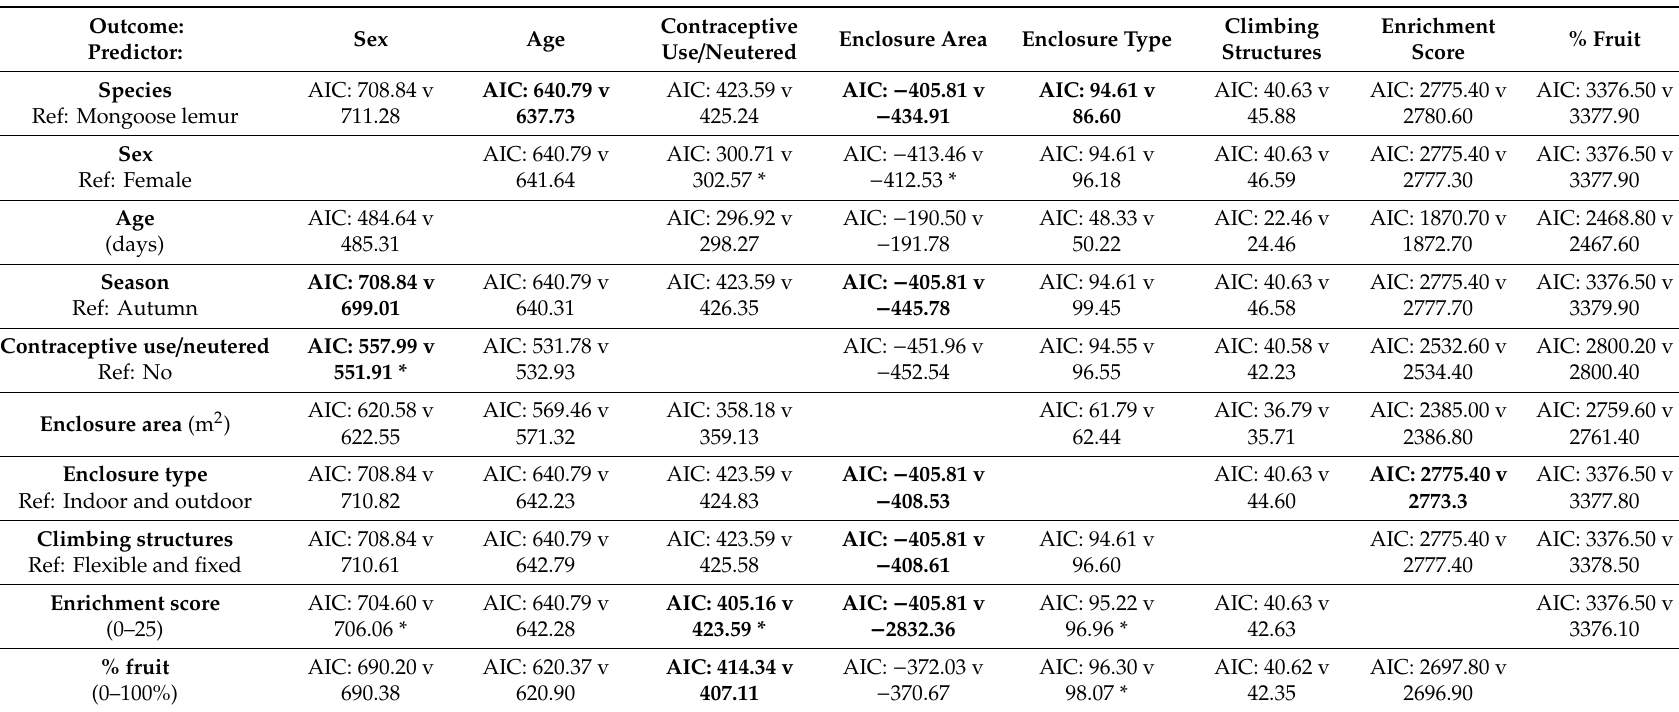
Table A4. Results of between-predictor checks for the epidemiological analyses. Note that species and season, being categorical with > 2 levels and nominal, were not analysable as outcome variables. In all cases, we first checked if varying intercepts only or intercepts and slopes were the best fit. In practice, varying intercepts and slopes were rarely a better fit than intercepts only, and these are indicated with an asterisk. Model comparisons were then made between the full model including the focal predictor and the null, using AIC (see Section 2.5.2). Associations between variables were confirmed if the full model yielded an improved fit, i.e., a lower AIC score by ≥ 2. The AIC of the null model is reported first. Full models found to be a better fit to the data than the null are shown in bold. For these, we assessed the nature of the relationship between the predictor and the outcome using the model’s coe ffi cients, and these are described in the text immediately below the